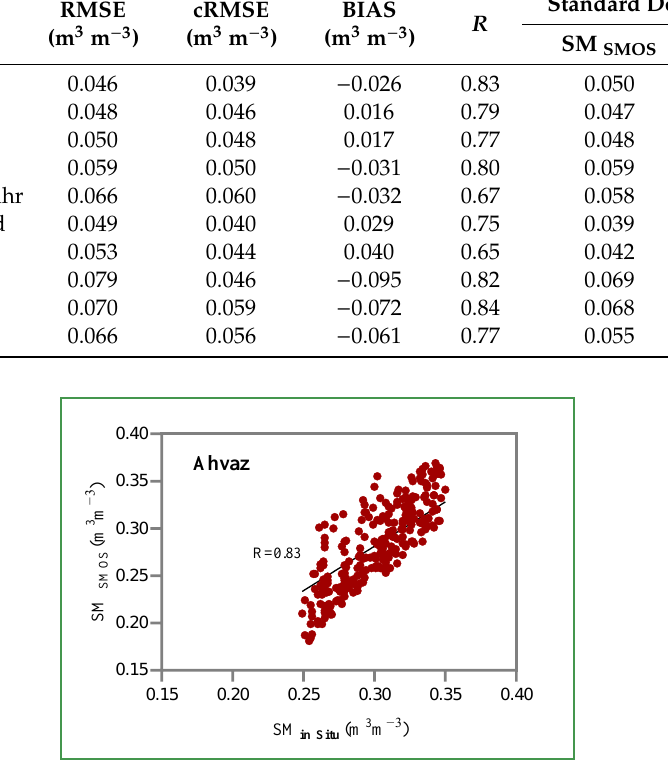
Figure 7. The scatterplots of SM SMOS against SM in situ for Ahvaz station.